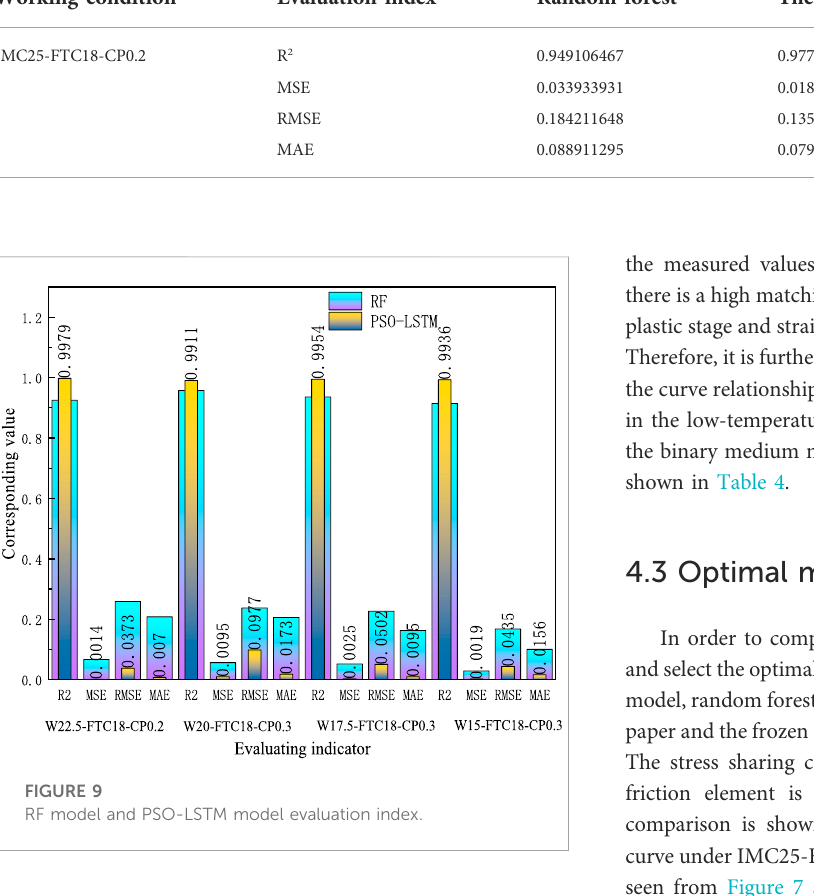
TABLE 5 Evaluation indicators of RF, theoretical calculation, PSO-LSTM model prediction and real data. Working